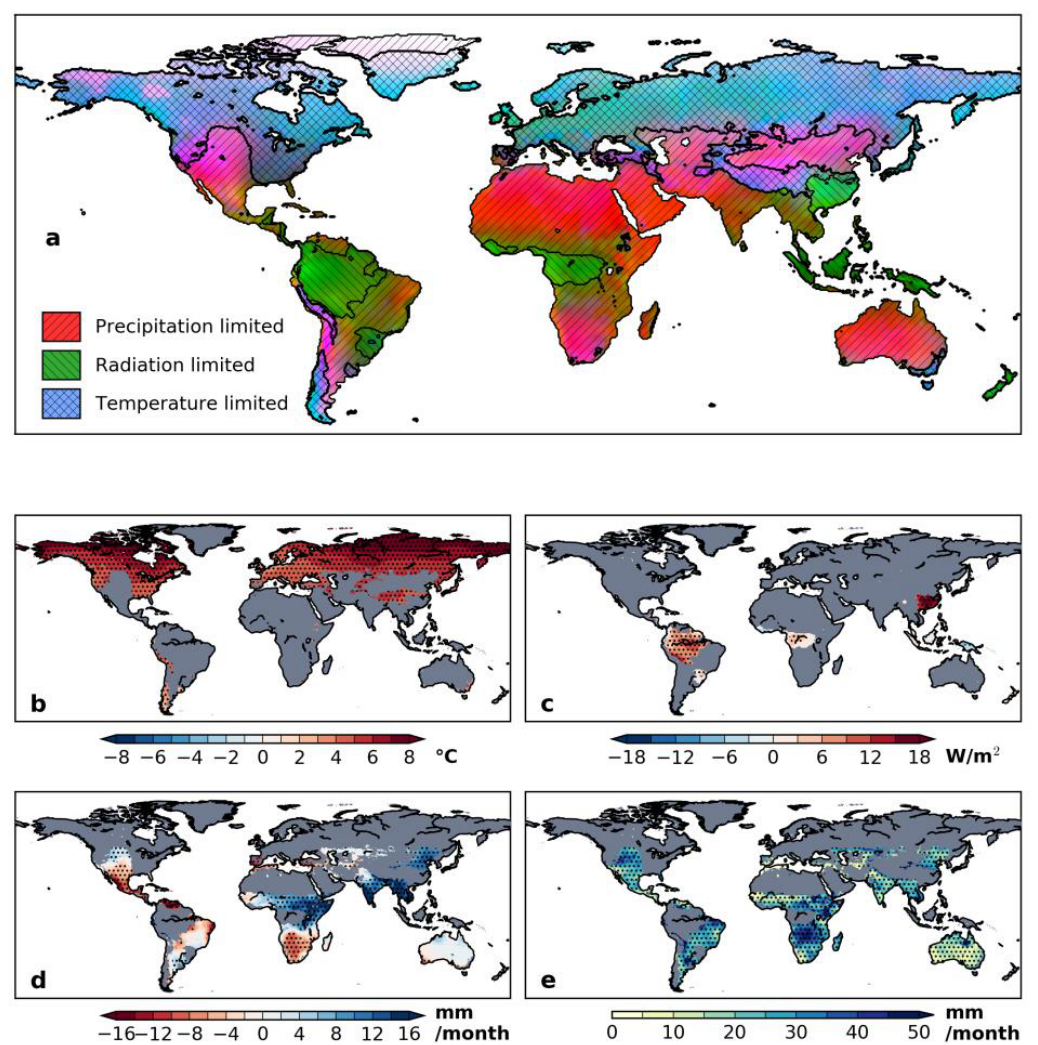
Figure 1. Earth system models project easing of temperature, precipitation, and radiation constraints to growth. A map of potential climate limiting factors to plant growth (( a ) air temperature in blue, precipitation in red, solar radiation in green) was used to guide the spatial analysis of simulated changes in climate and how such changes could impact plant growth around the world. Using outputs from Earth system models of CMIP5 we estimated ensemble mean differences in 2090–2099 minus 2006–2015 monthly air temperature ( b ), solar radiation ( c ), precipitation ( d ), and precipitation use efficiency (expressed as precipitation equivalent; see Methods) ( e ). Changes in constraints by regional mean: temperature-limited, easing 94%, and no significant change 6%; precipitation-limited, easing 23%, tightening 16%, and no significant change 61%; radiation-limited, easing 45%, tightening 19%, and no significant change 36%.